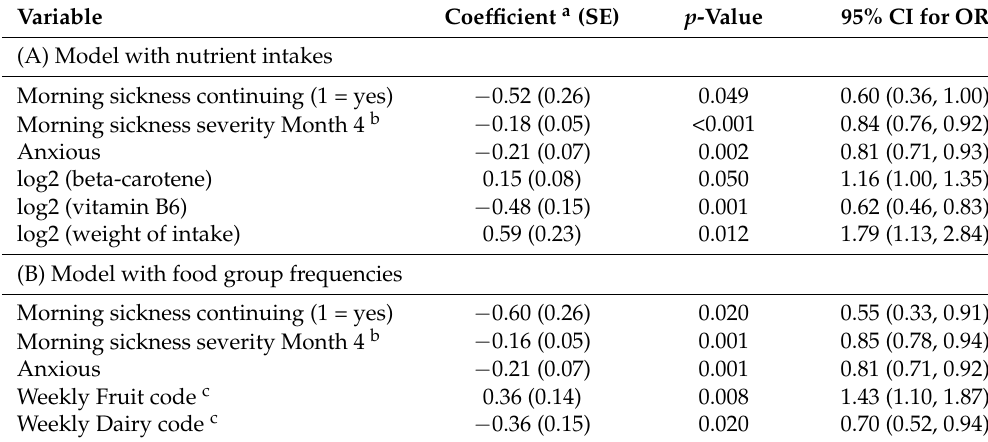
Table 7. Ordinal logistic regression for difficulty sleeping in the third trimester: (A) with nutrient intakes; (B) with food group